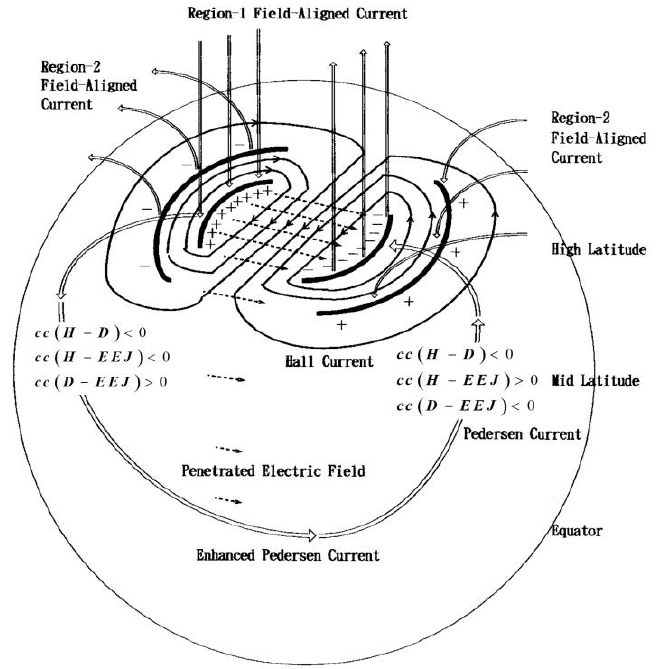
Figure 1. Schematic diagram of the DP2 ionospheric currents modified from Figure 9 of Kikuchi et al. [3]. Two-cell Hall currents surround the Region-1 field-aligned currents at high and middle latitudes. The R1FAC drives a current circuit with midlatitude Pedersen current and equatorial Cowling current (enhanced Pedersen current, EEJ ). cc ( H - D ), cc ( H-EEJ ), and cc ( D-EEJ ) refer to correlations between midlatitude H and D and correlations between H / D and EEJ .